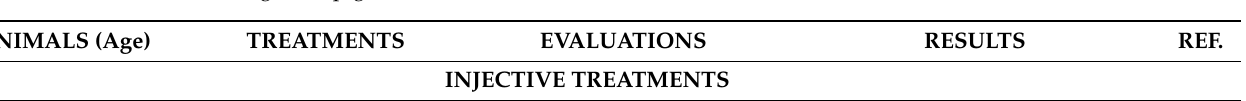
Table 2. Preclinical in vivo studies evaluating treatments in naturally occurring OA in DH guinea